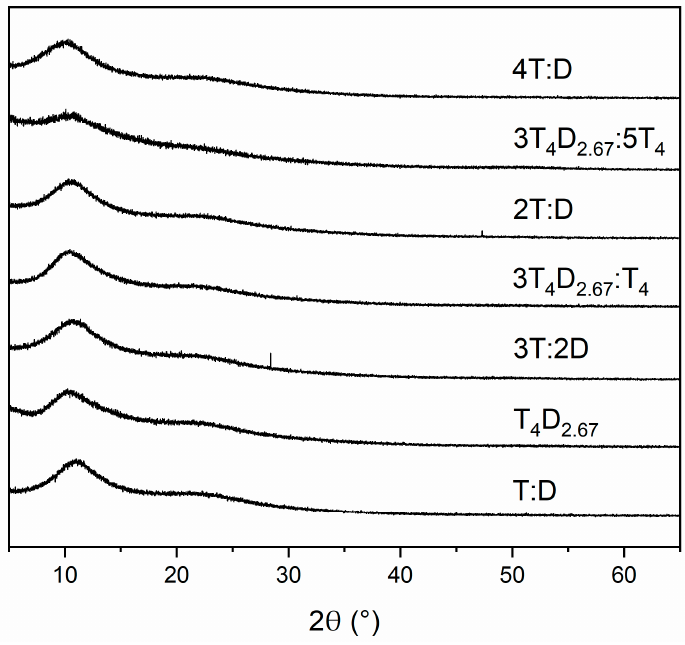
Figure 5. XRD analysis of precursors.